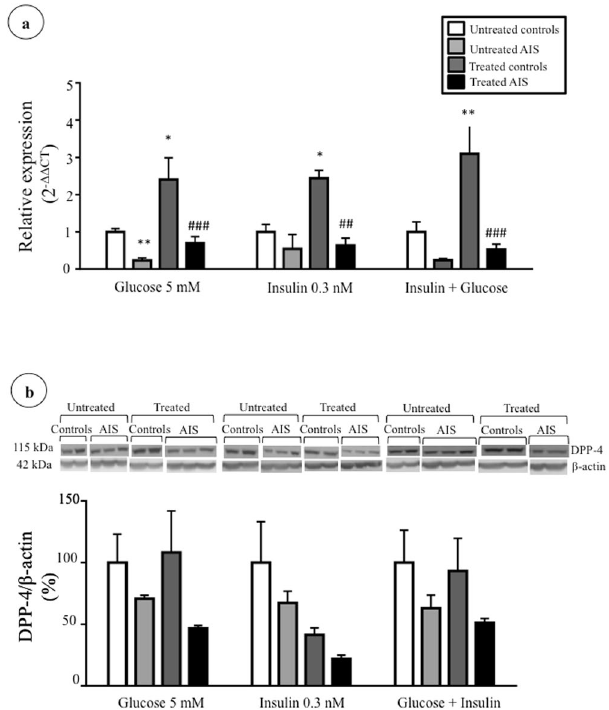
Figure 4. Impact of long-term treatments with glucose and insulin on DPP-4 expression. Cells were treated with glucose (5 mM), insulin (0.3 nM) and glucose + insulin (5 mM and 0.3 nM) for 24 hours. ( a ) DPP4 gene expression in osteoblasts of controls (n = 3) and AIS patients (n = 4–6) was measured by RT-qPCR with GAPDH as endogenous control. Relative expression was analyzed with the 2 −ΔΔ CT method. ( b ) DPP-4 protein expression in osteoblasts of controls and AIS patients (n = 3/group) was measured by Western blot with β -actin as endogenous control. * P < 0.05 and ** P < 0.01 vs. untreated controls; ## P < 0.01 and ### P < 0.001 vs. treated controls using one-way ANOVA followed by Tukey’s post-hoc tests. Data are presented as mean ± standard